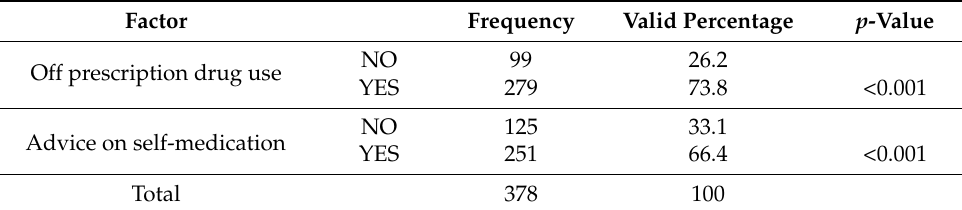
Table 2. Frequency of off-prescription drug use in the last month and advice on self-medication.